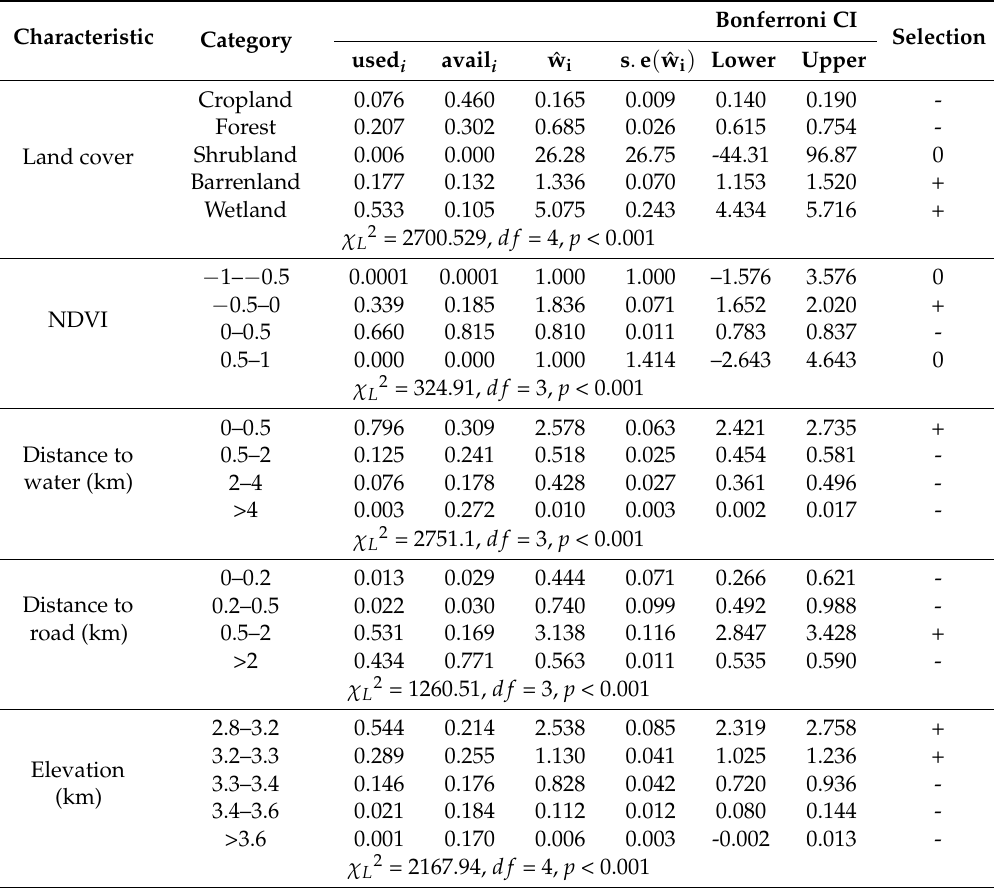
Table 4. The result of Manly’s habitat selection ratios for Bar-headed Geese (Anser indicus) captured at Qinghai Lake in 2007 and 2008. The selection ratio ˆ w i for each category i is calculated as ˆ w i = used i /avail i